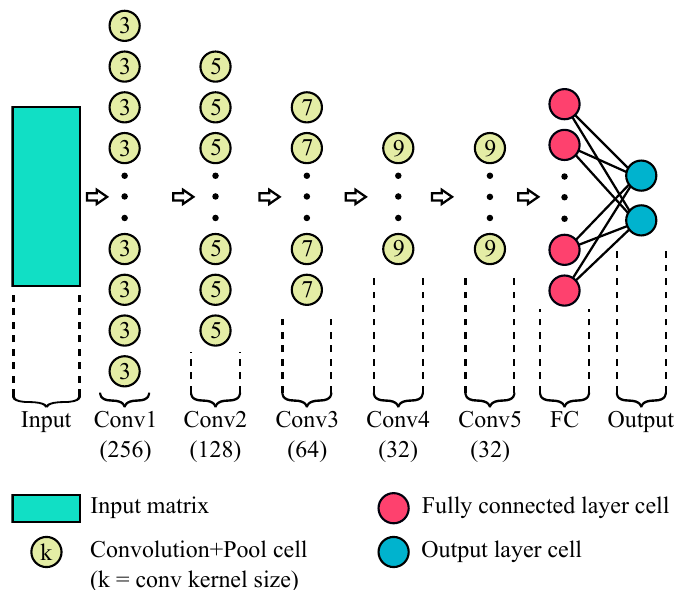
Figure 5. Description of the implemented CNN structure. The number between parenthesis below each convolutional layer represents the number of convolutional filters in that layer.